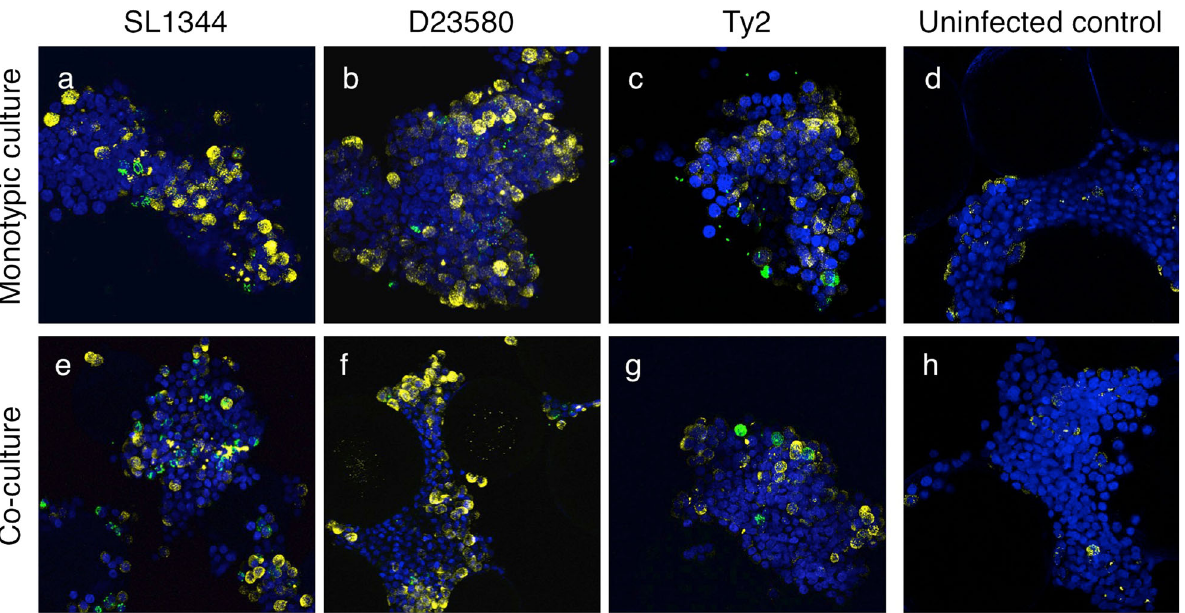
Fig. 8 MUC5AC production by the 3-D co-culture and 3-D epithelial models following infection with Salmonella pathovars cultured under microaerobic conditions. The 3-D co-culture model ( a – d ) and 3-D epithelial model ( e – h ) were fi xed 24 h.p.i. with either SL1344 ( a , e ), D23580 ( b , f ) or Ty2 ( c , g ) that had been cultured under microaerobic conditions. Time-matched uninfected controls are shown ( d , h ). Cultures were co-stained with a MUC5AC antibody ( yellow ), an anti- Salmonella antibody ( green ), and the cell nuclei stained with DAPI ( blue ). Magni fi cation =